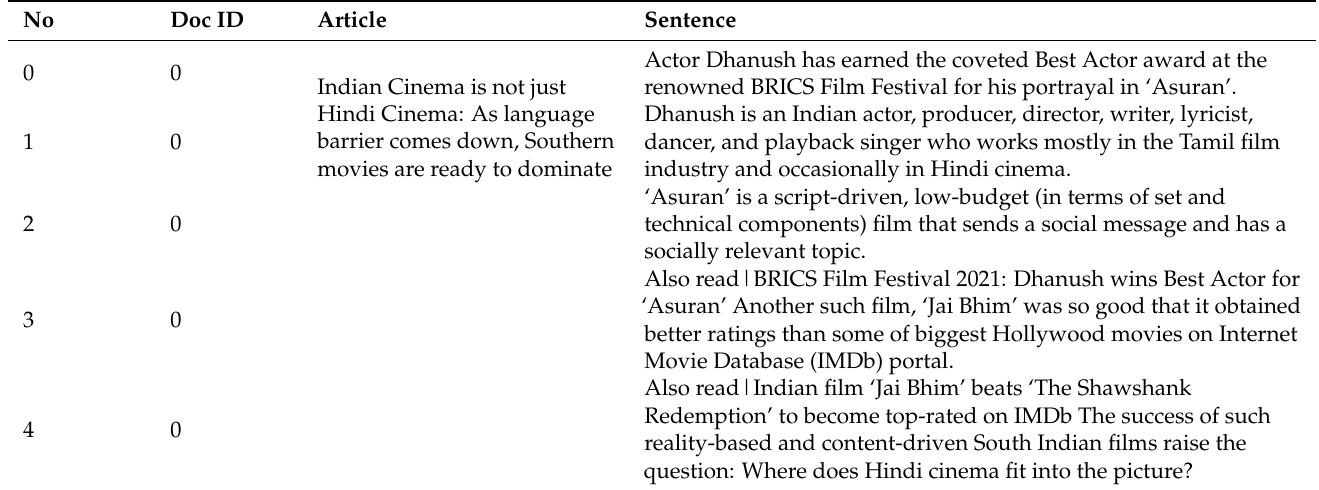
Table 2. Sentences obtained from news articles for “India film